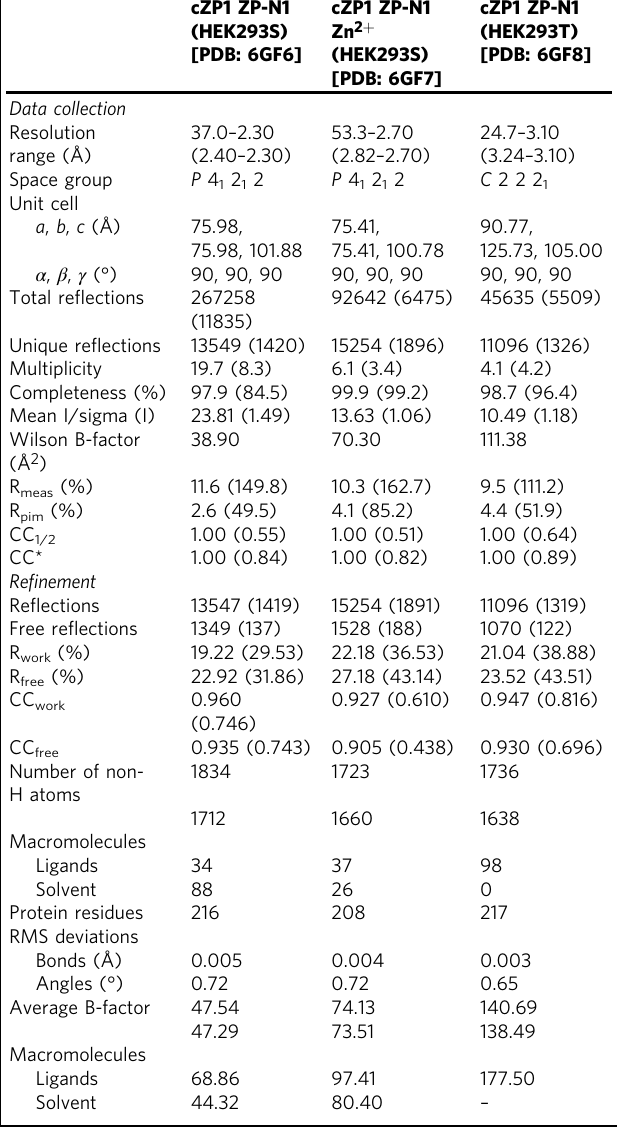
Table 1 X-ray data collection and re fi nement